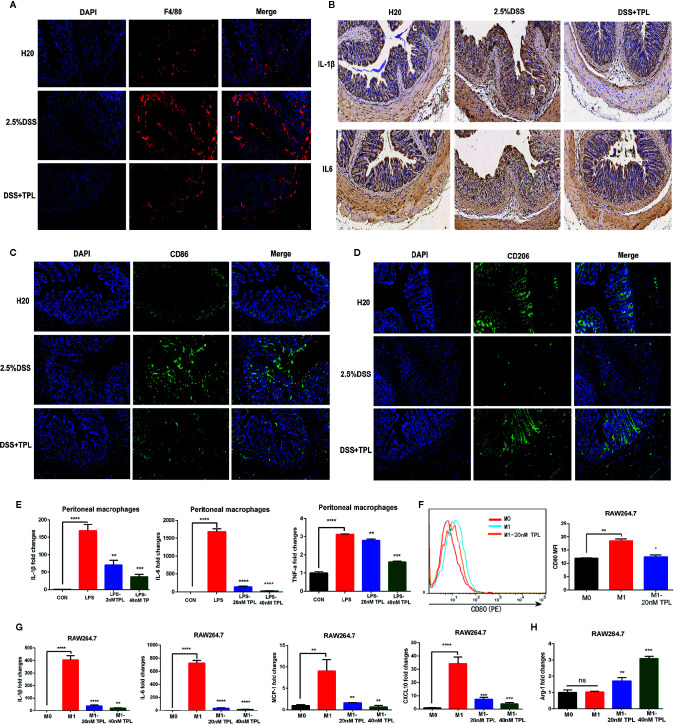
Triptolide inhibited macrophage infiltration and inflammatory cytokines in vivo and in vitro. Mice aged 6–8 weeks were treated with 2.5% DSS with or without triptolide administration. (A) The F4/80 expression was measured by immunofluorescence assay. (B) The IL-1β and IL-6 level of colitis was detected by immunohistochemistry assay. RAW 264.7 macrophages were treated with 1,000 ng/ml lipopolysaccharide (LPS) with 0–40 nM triptolide for 24 h. (C) The CD86 expression was measured by immunofluorescence assay. (D) The CD206 expression was measured by immunofluorescence assay. (E) RT-qPCR was used to measure the levels of proinflammatory cytokines such as IL-1β, IL-6, and TNF-α. RAW 264.7 macrophages were treated with 500 ng/ml LPS and 100 ng/ml IFNγ, then incubated with 0–40 nM triptolide for 24 h. (F) Flow cytometry was performed to determine the expression of CD80, a M1-mediated surface marker. (G) RT-qPCR was used to measure the levels of M1-mediated cytokines such as IL-1β, IL-6, MCP-1, and CXCL10. (H) RT-qPCR was used to measure the levels of M2-mediated cytokines including Arg-1. β-actin served as an internal control. Data are shown as the mean ± SD of at least three independent experiments. *P < 0.05; **P < 0.01; ***P < 0.001; ****P < 0.0001; and ns means no significance.